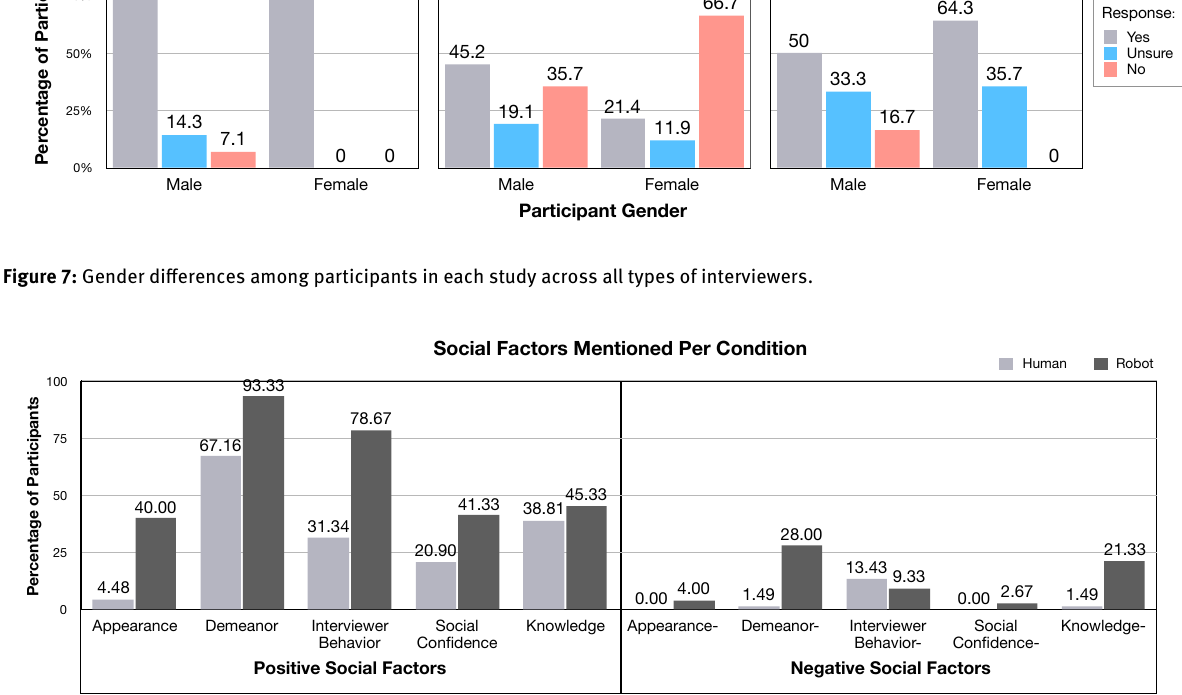
ceived the ability of robot and human interviewers to un- derstand what they were saying, how they felt, and to